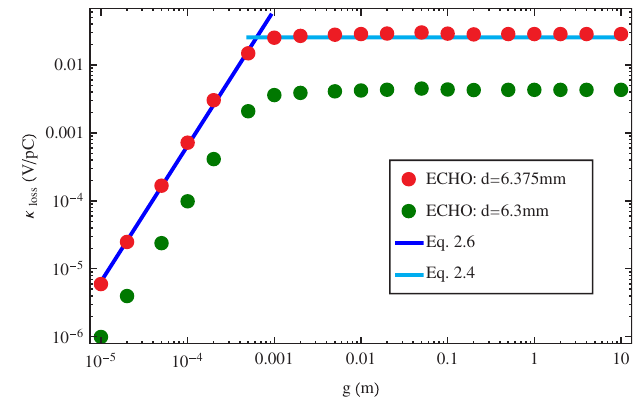
FIG. 7. (Color) For a Gaussian bunch of rms length (cid:1) ¼ 0 : 5 mm , we show the results of ECHO calculation of the loss factor as a function of gap g for a pillbox cavity with parameters d ¼ 6 : 375 mm , b ¼ 6 : 25 mm (red dots) and d ¼ 6 : 3 mm , d ¼ 6 : 25 mm (green dots). The blue line is given by Eq. (2.6) in the slot regime and the aqua line represents Eq. (2.4) which holds in both the cavity and the step regimes for small d (cid:2) b .